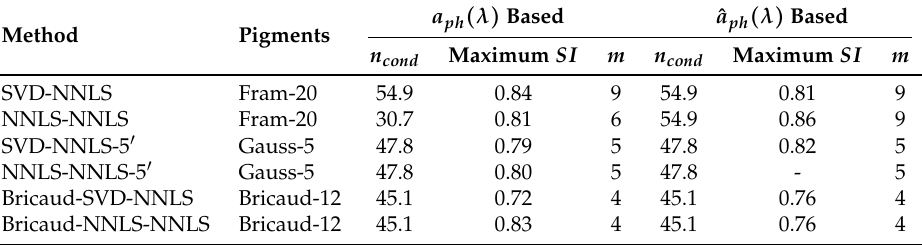
Table 4. Statistics for the Model-1 linear regressions between SVD-NNLS retrieved and measured pigment concentrations (regression coefficients were calculated with 95% confidence bounds). MAE is in mg m − 3 (values outside the parentheses were calculated with linear-scale values, while inside the parentheses with log10-scale values), MPE in %, and N is the number of data points for the regressions. Unperturbed training data set was